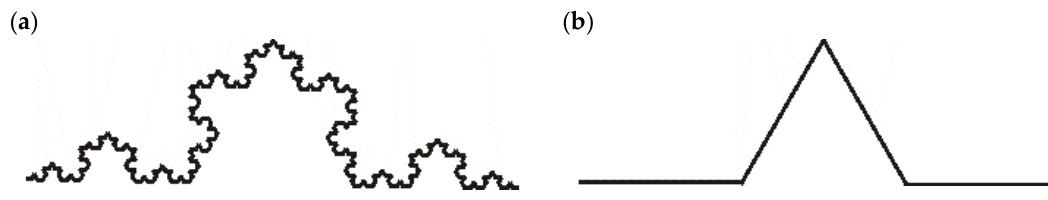
Figure 4. Koch curve in the fourth formation step ( a ) and the “pattern” of its formation—generator ( b ).